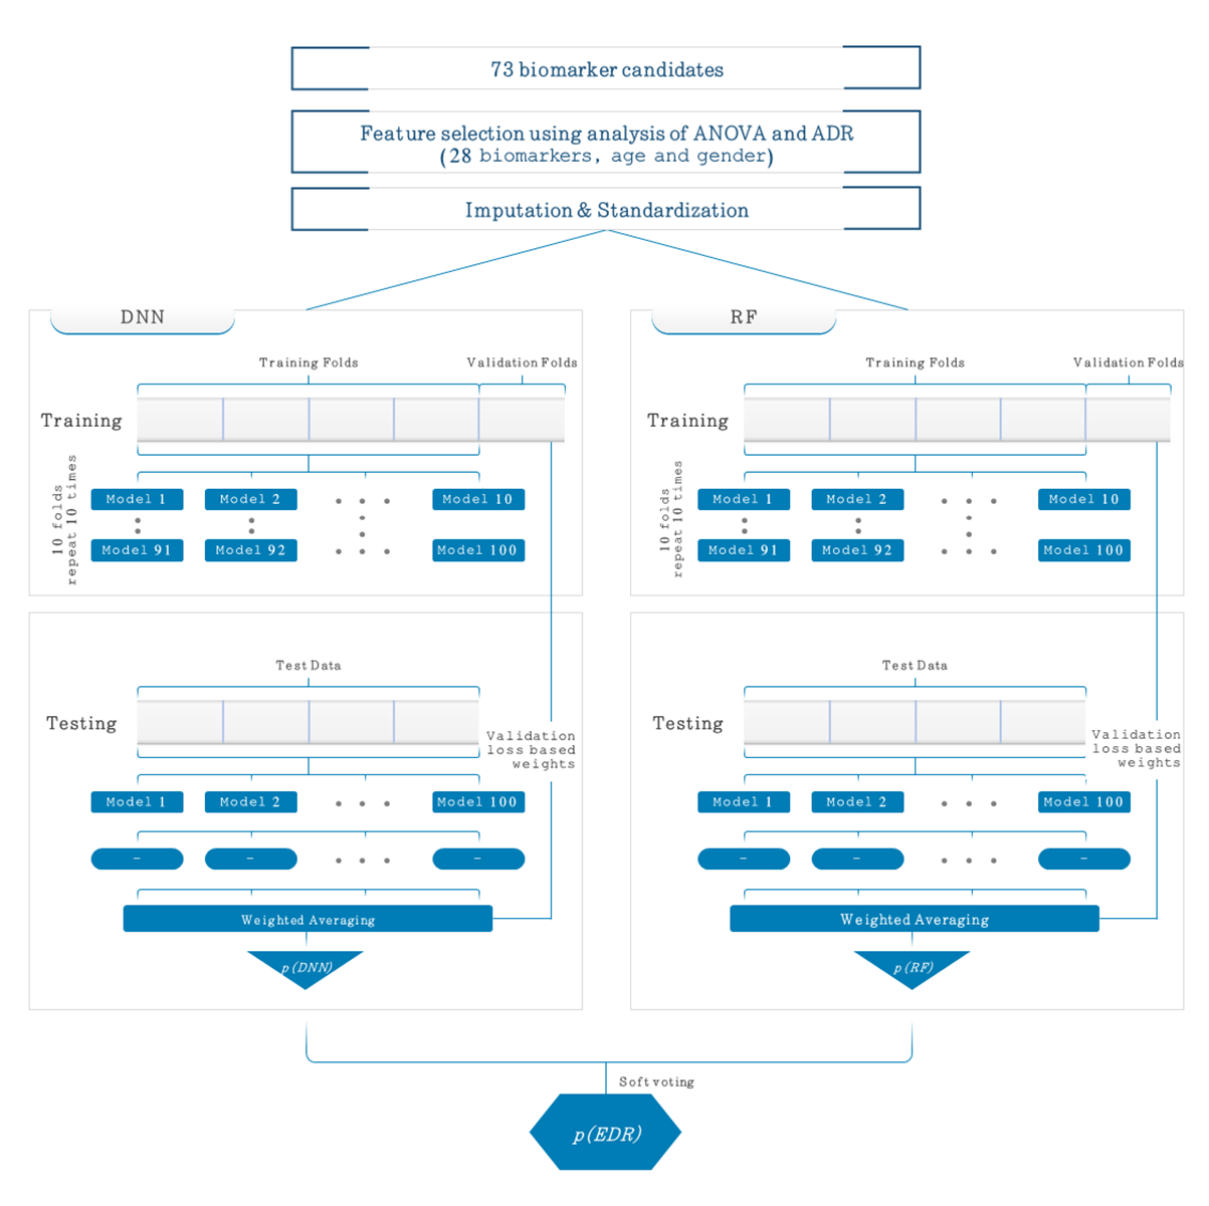
Figure 1. Proposed ensemble model (EDRnet) composed of a 5-layer deep neural network (DNN) and random forest (RF) model for the mortality prediction. In the training of both models, a 10-time-repetition 10-fold stratified cross-validation was separately performed, and the predicted mortality probabilities of the DNN model, p(DNN), and the RF model, p(RF), were calculated. The final predicted mortality probability of the ensemble model, p(EDR), was obtained by soft voting based on the p(DNN) and the p(RF). ADR: available data rate; ANOVA: analysis of variance; EDRnet: ensemble learning model based on DNN and RF